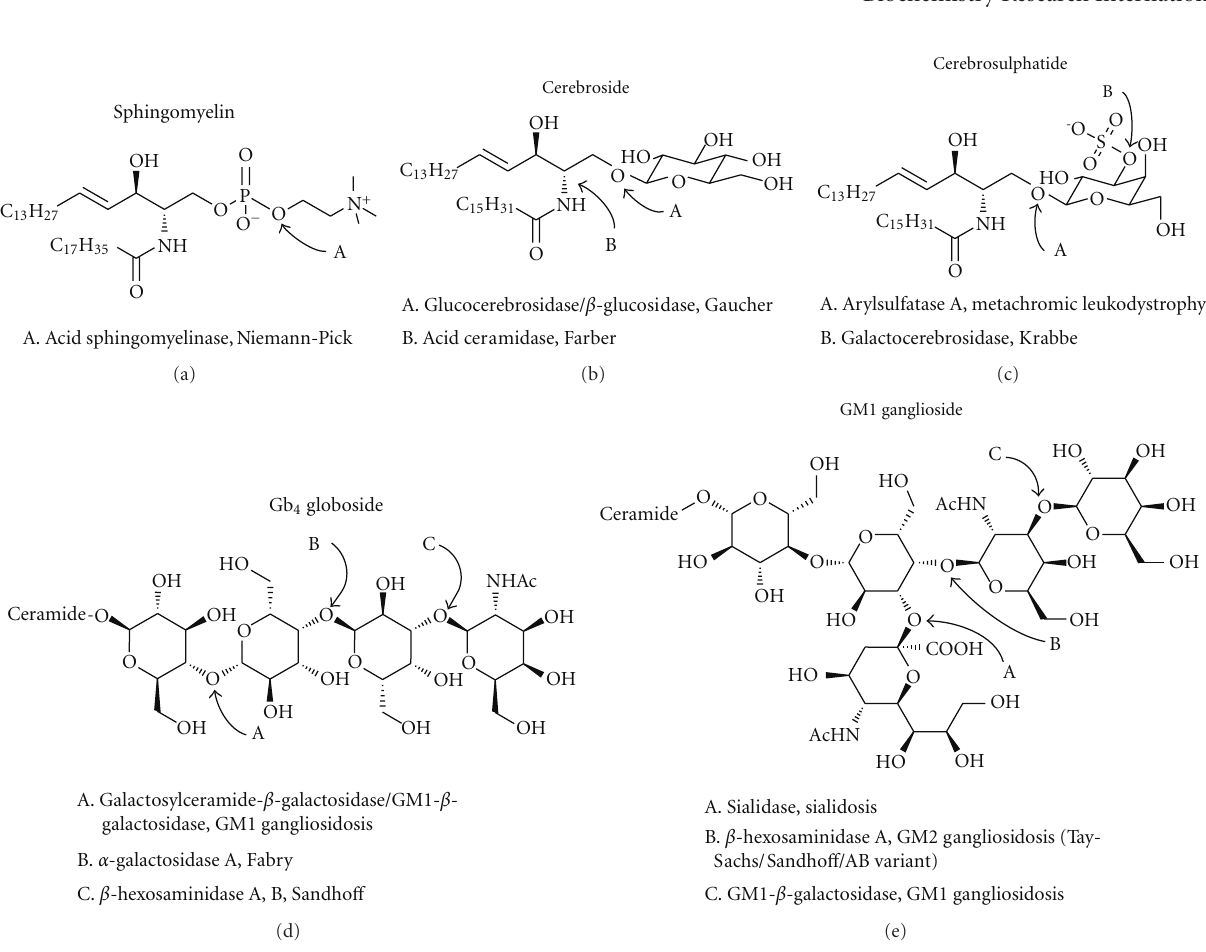
Figure 4: Defects in mammalian sphingolipid catabolism and their associated sphingolipidoses. The enzymes responsible are indicated at the glycosidic linkages on which they